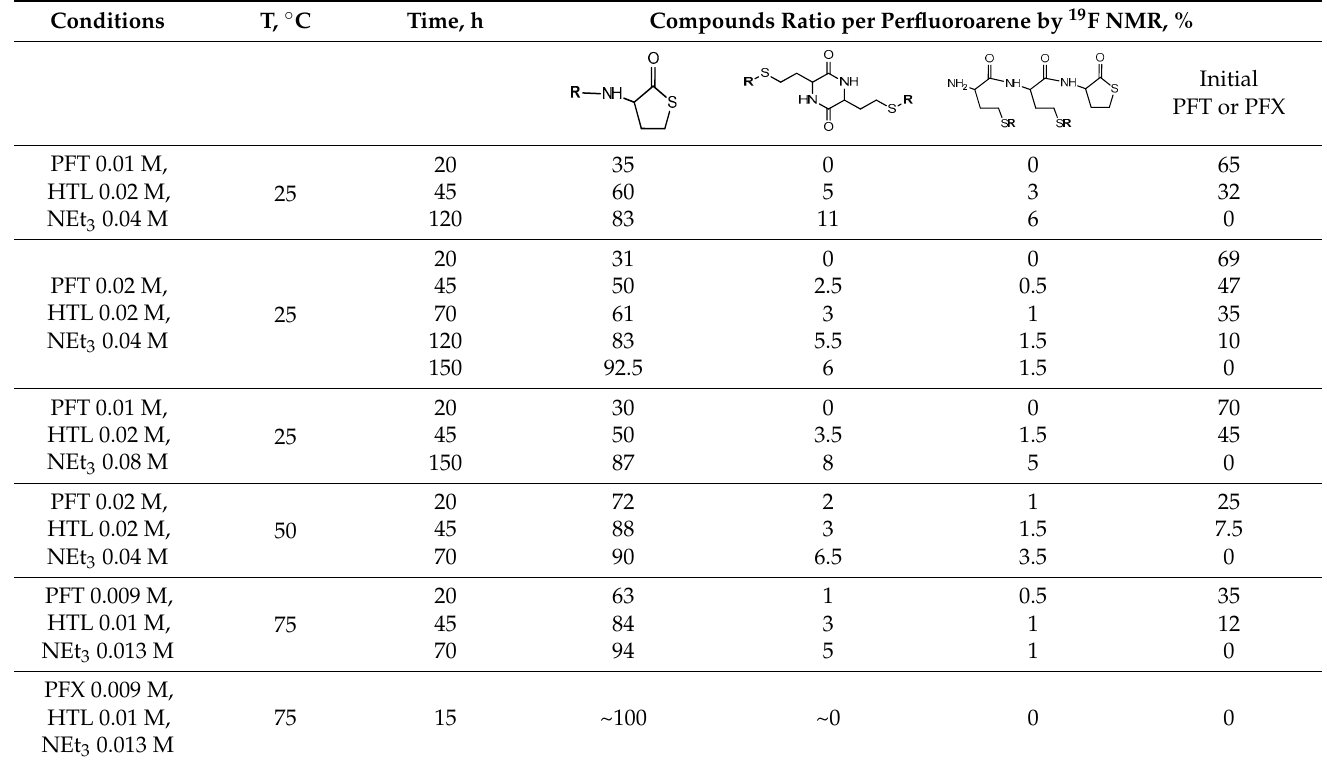
Table 2. The ingredients, reaction conditions, and products of the reaction between HTL and perfluoroarenes in the presence of triethylamine in DMSO.